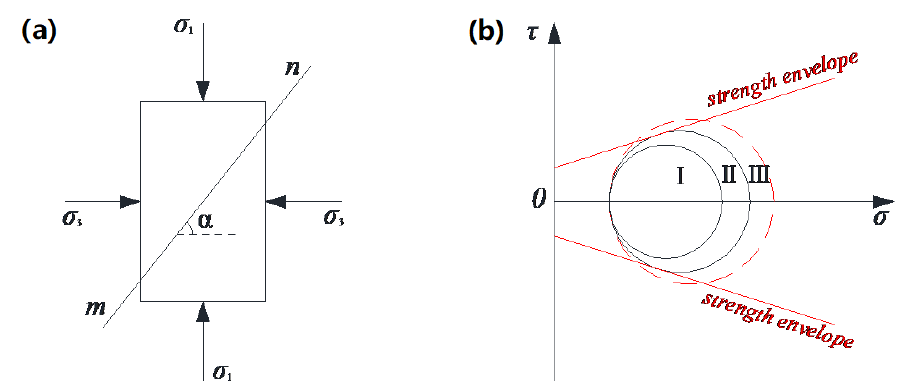
Figure 5. Schematic of Mohr–Coulomb failure criterion: ( a ) Failure surface ( b ) Envelope lines.